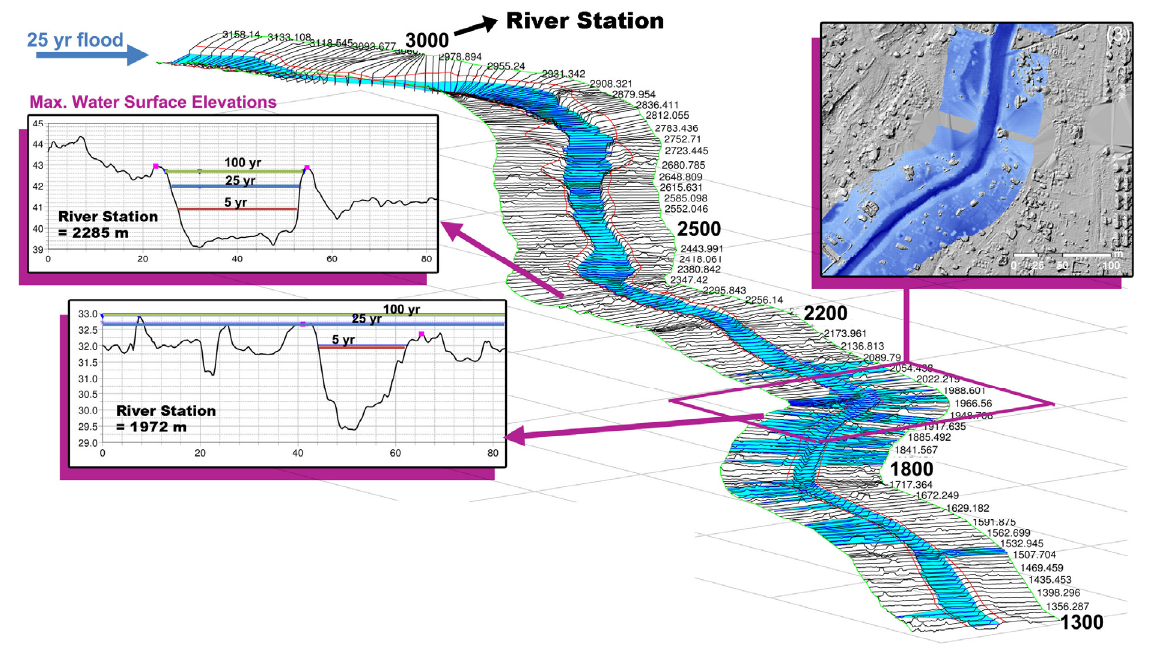
Figure 16. Maximum water surface for a 25 year ARI flood in 3D view and for a five, 25 and 100 year ARI flood for two channel cross sections (river station 2285 and